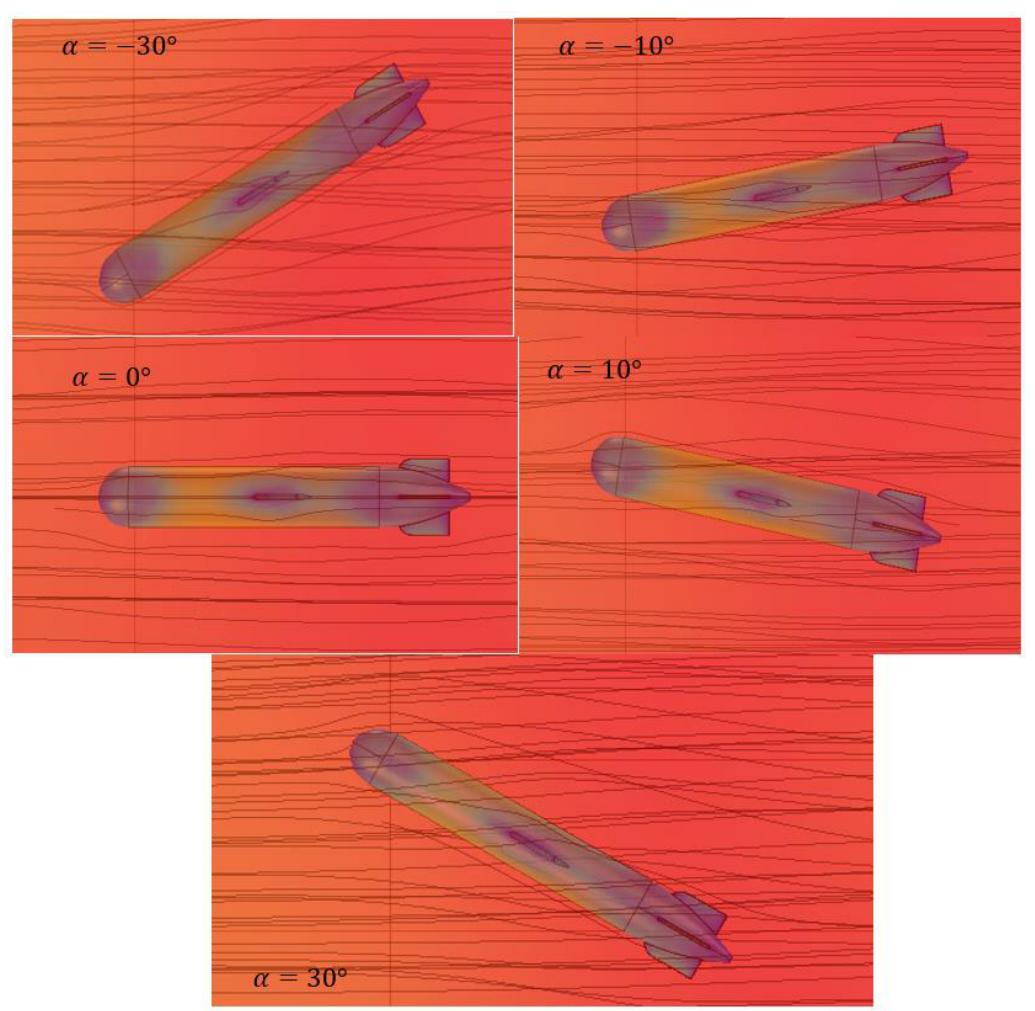
Figure 10. Streamlines around the underwater glider with U = 1 m/s at different angles of attack.